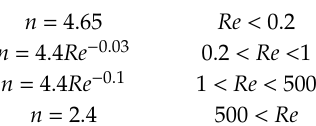
Figure 17. The variation of drag reduction rate between HELV and HPG at different shear rates.